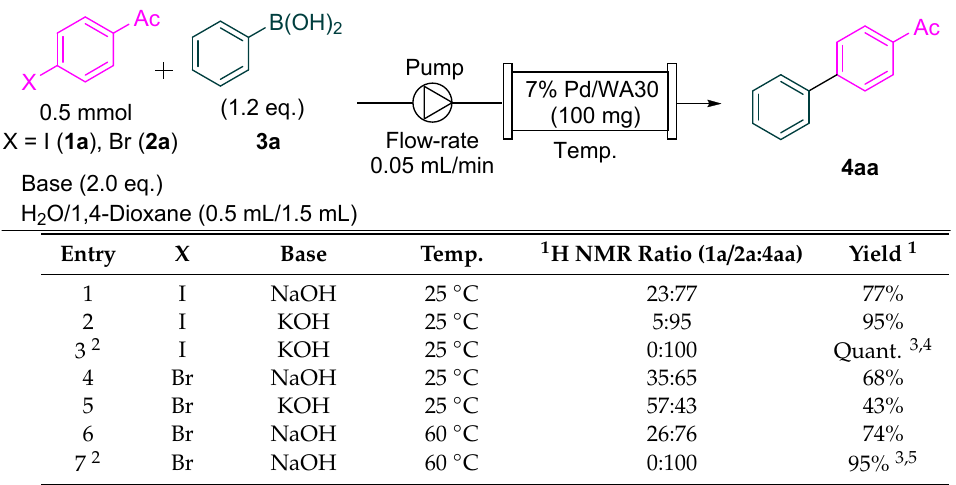
Table 1. Optimization of the 7% Pd / WA30-catalyzed continuous-flow Suzuki–Miyaura coupling reaction of 4 (cid:48) -iodo and 4 (cid:48) -bromo acetophenone ( 1a and 2a ) with phenylboronic acid ( 3a ).